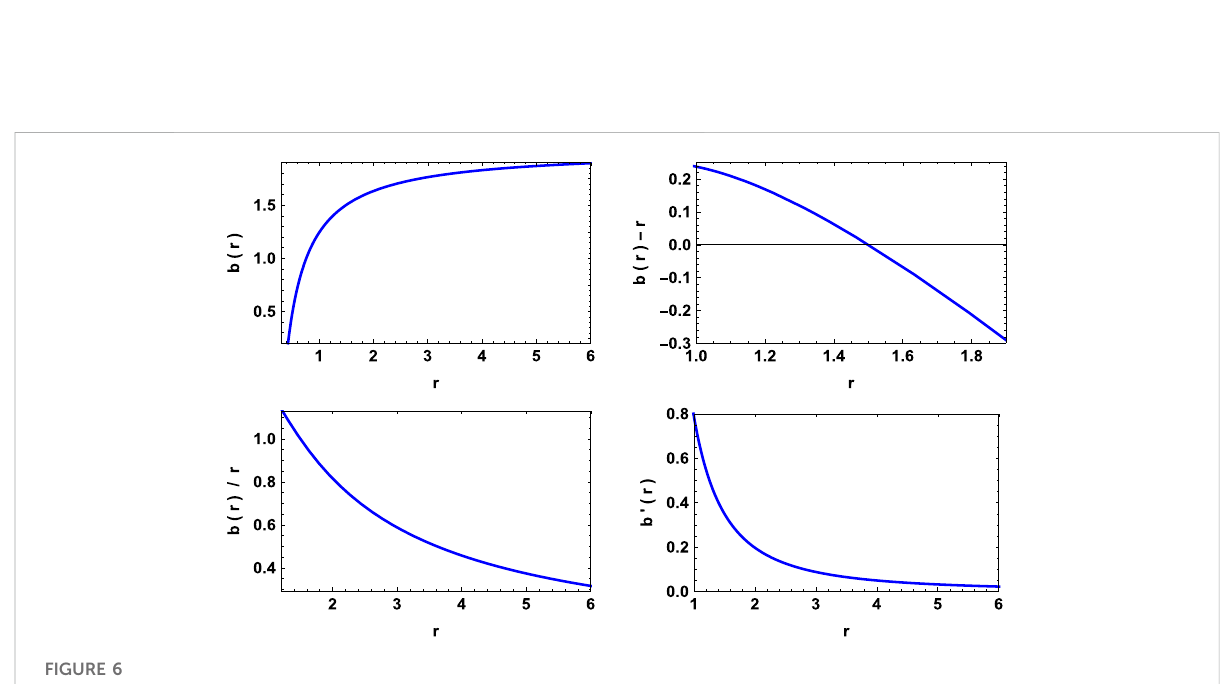
FIGURE 6 Variation of b , b − 2, b / r and b ′ ( r ) for model III with a = 1.5, λ = 1.2, ω = − 2, c =